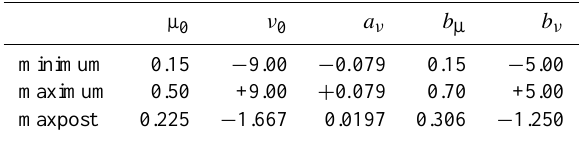
Table 1. Prior and posterior characterization. The prior distribution is uniform on a 5-dimensional grid, with 21 equally-spaced nodes along each axis between the minimum and the maximum values reported. The time increment a ν is measured in ν units per year. The posterior distribution is computed on the same support, and has its maximum value at the vector indicated as “maxpost”.